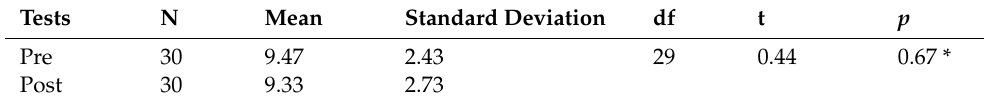
Table 4. This is a table of results using conventional learning in physics of the control group. Tests N Mean Standard Deviation